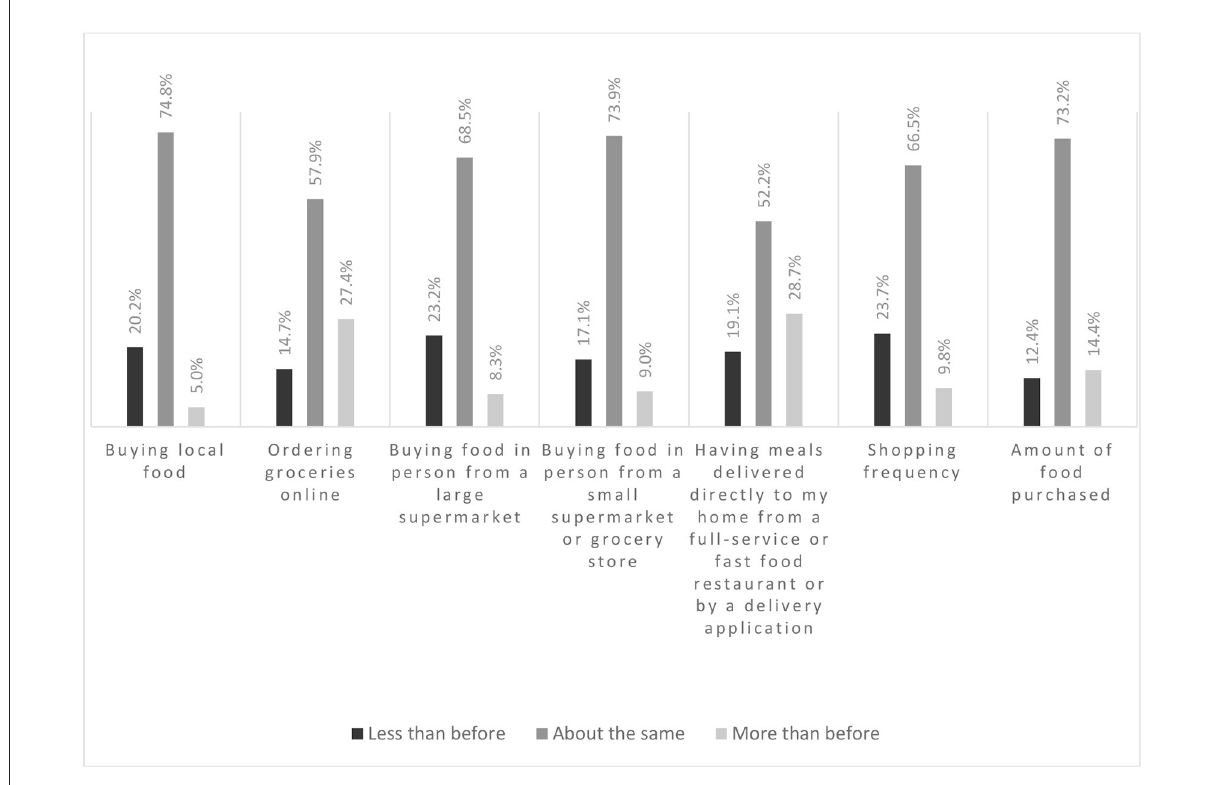
FIGURE1 Changes in food shopping behavior after the availability of the COVID-19